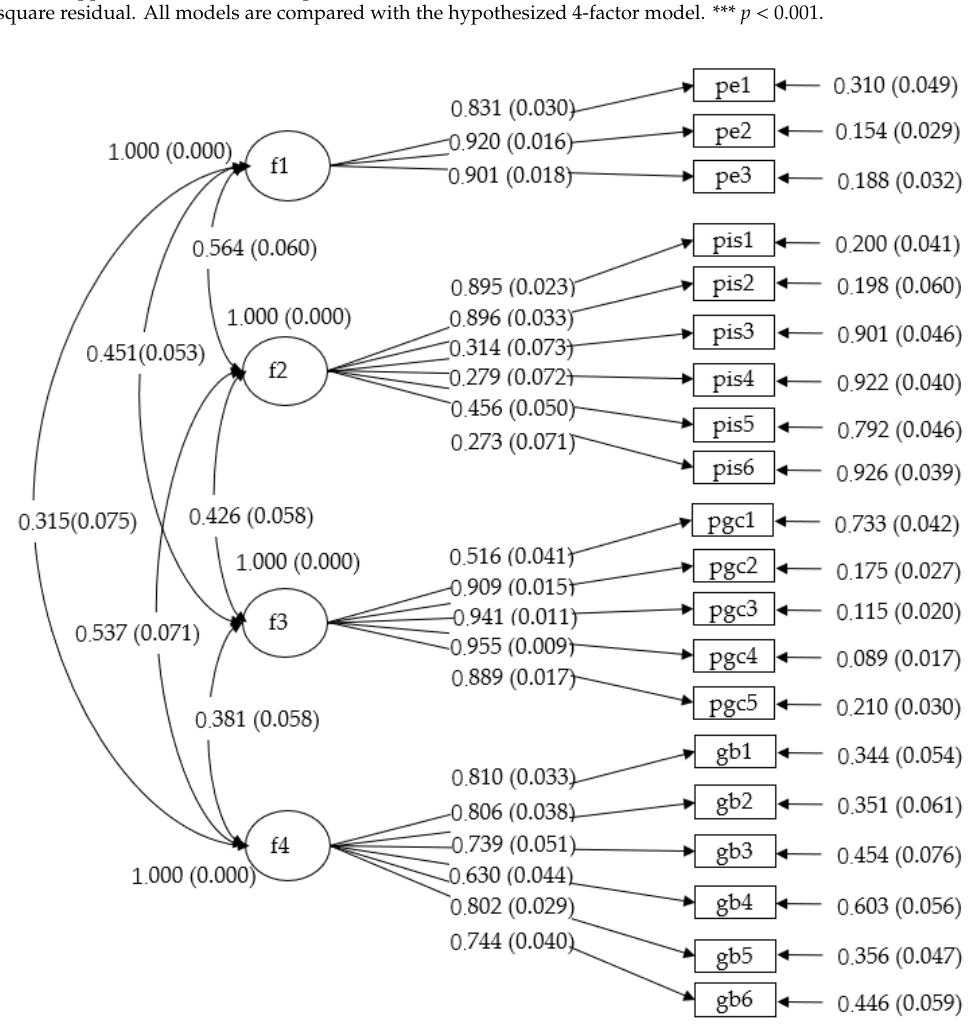
Figure 2. The graphical representation of the measurement model for the hypothesized 4-factor model. Notes : f1 = employee-organization fit; f2 = perceived insider status; f3 = green organizational climate; f4 = voluntary green behavior. Values in parentheses are standard error